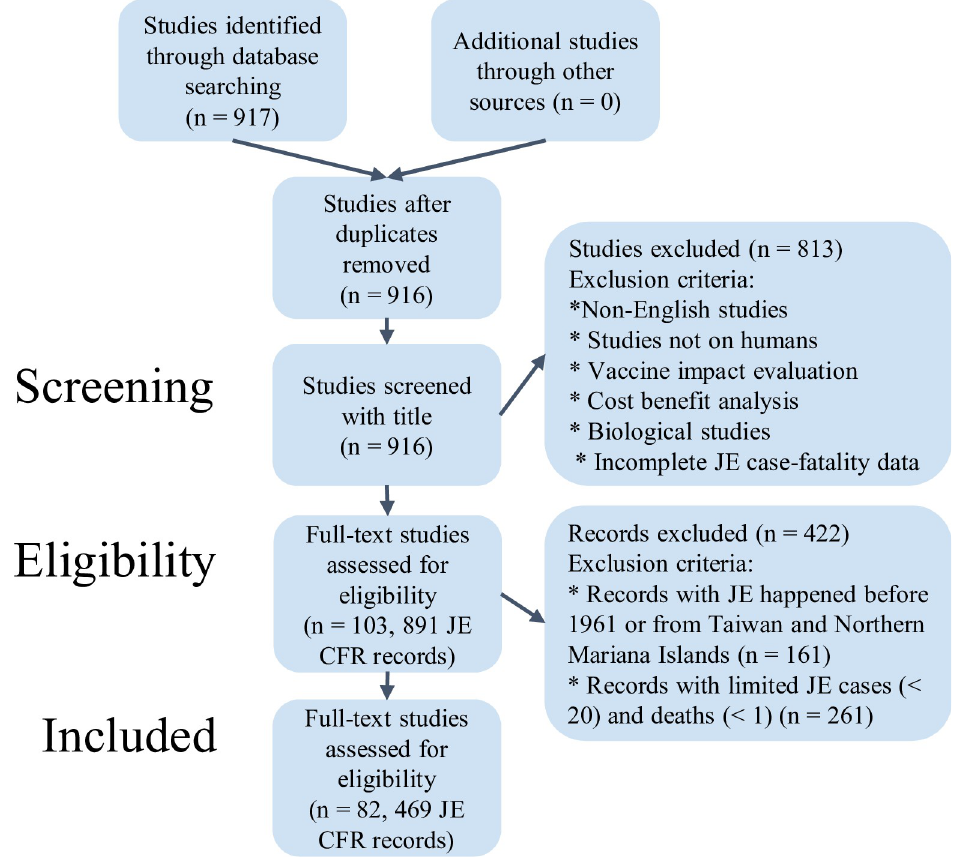
Fig 1. Flowchart describing the systematic review procedure searching for Japanese encephalitis (JE) case-fatality ratio (CFR) records using the PubMed database.